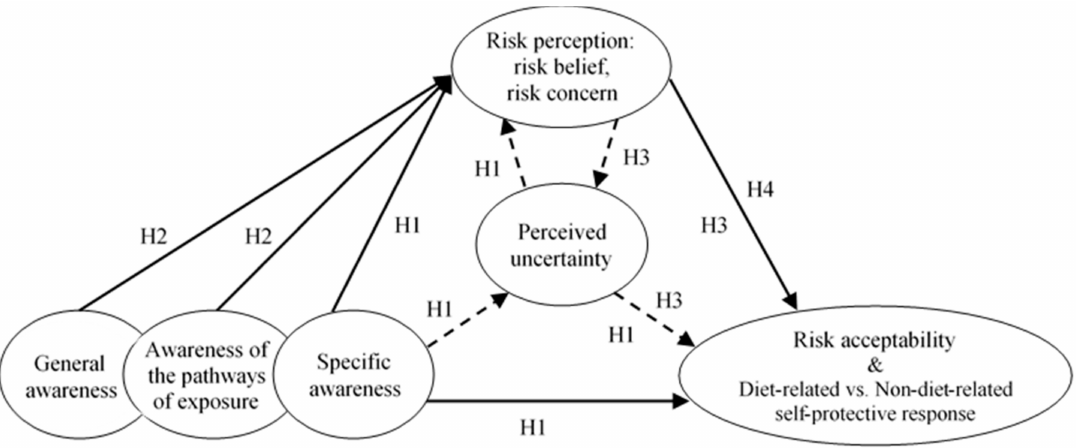
Figure 2. Modified hypothesized concept